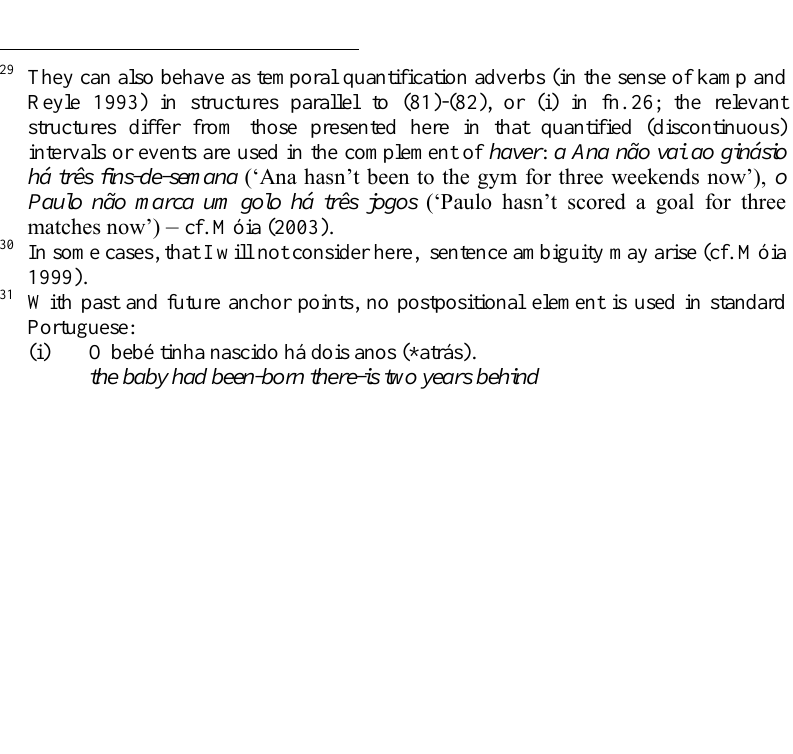
section 6: phrases with e.g. dentro de or daí/daqui a , in Portuguese, em in Brazilian Portuguese, and in , in English (cf.